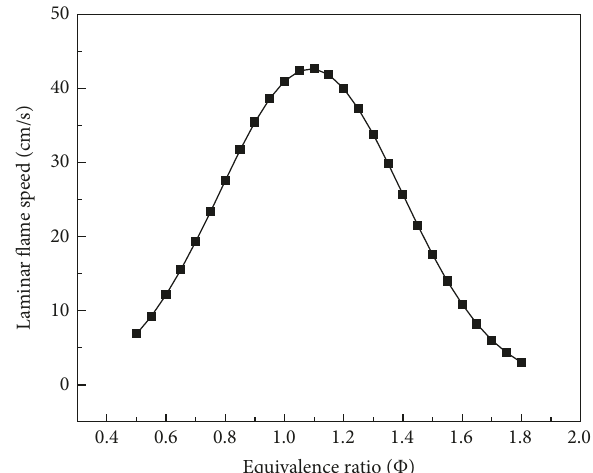
Figure 1: Laminar flame speed of natural gas combustion.